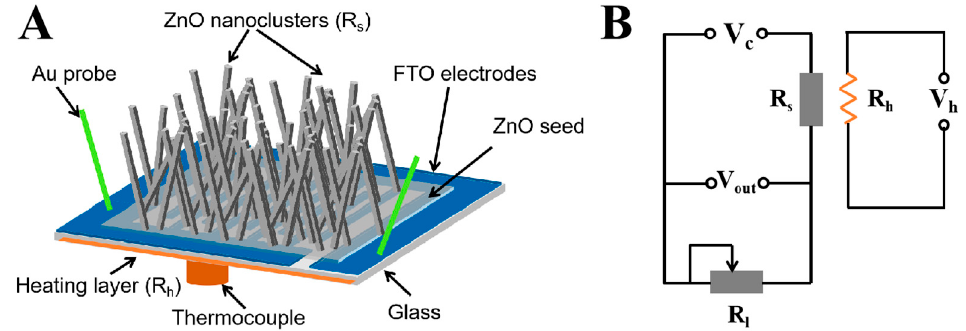
Figure 1. ( A ) The schematics of the ZnO NCs gas sensor and ( B ) the electric circuit of the sensor analysis